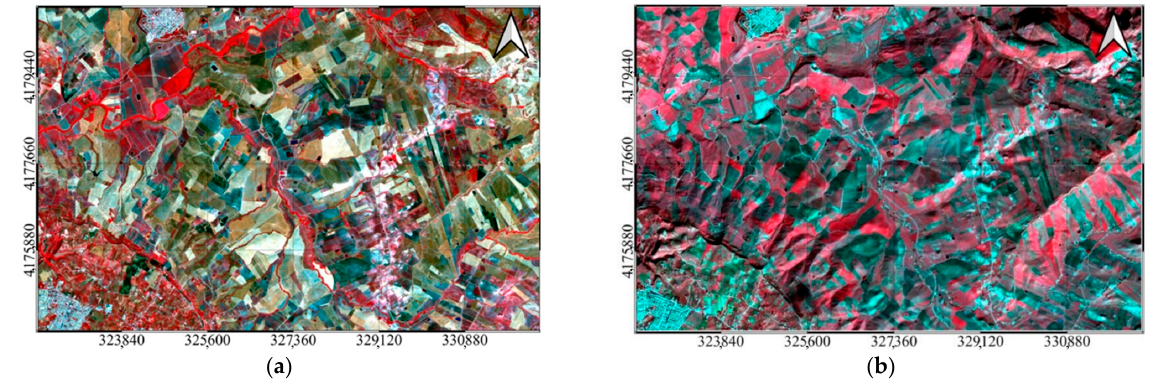
Figure 2. Pilot area. CIR composition of the selected images for the arid ( a ) and temperate ( b ) periods.